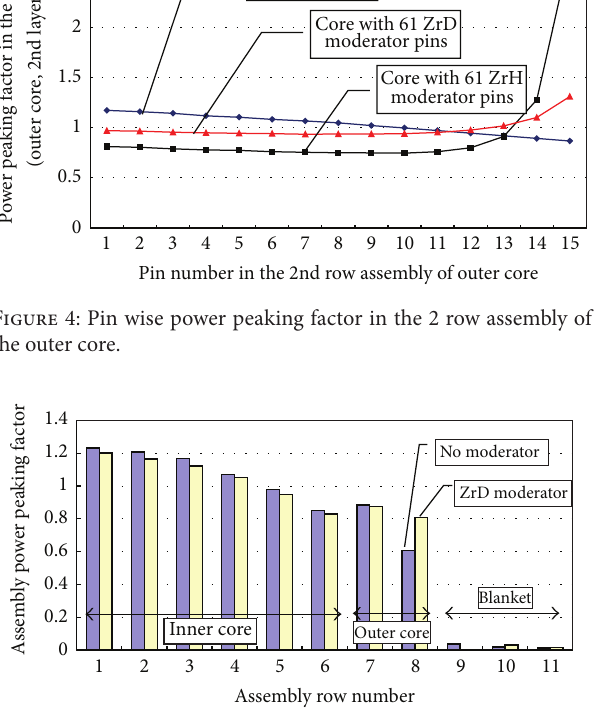
Figure 3: Details of pin arrangement at outer core region.